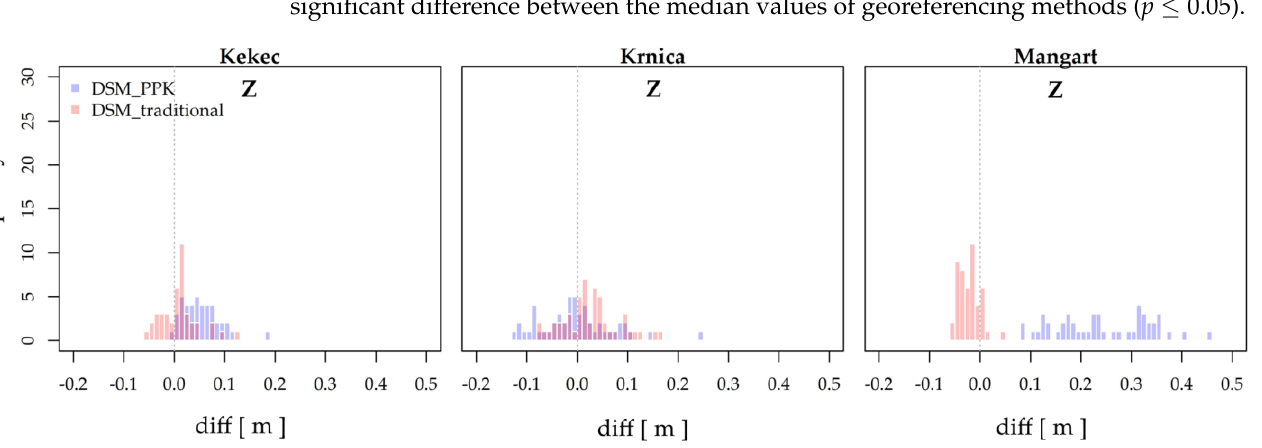
Figure 8. Frequency distribution of the Z coordinates differences at all three rockfall sites for DSM_traditional and DSM_PPK. Bar width is set to 0.01 m.